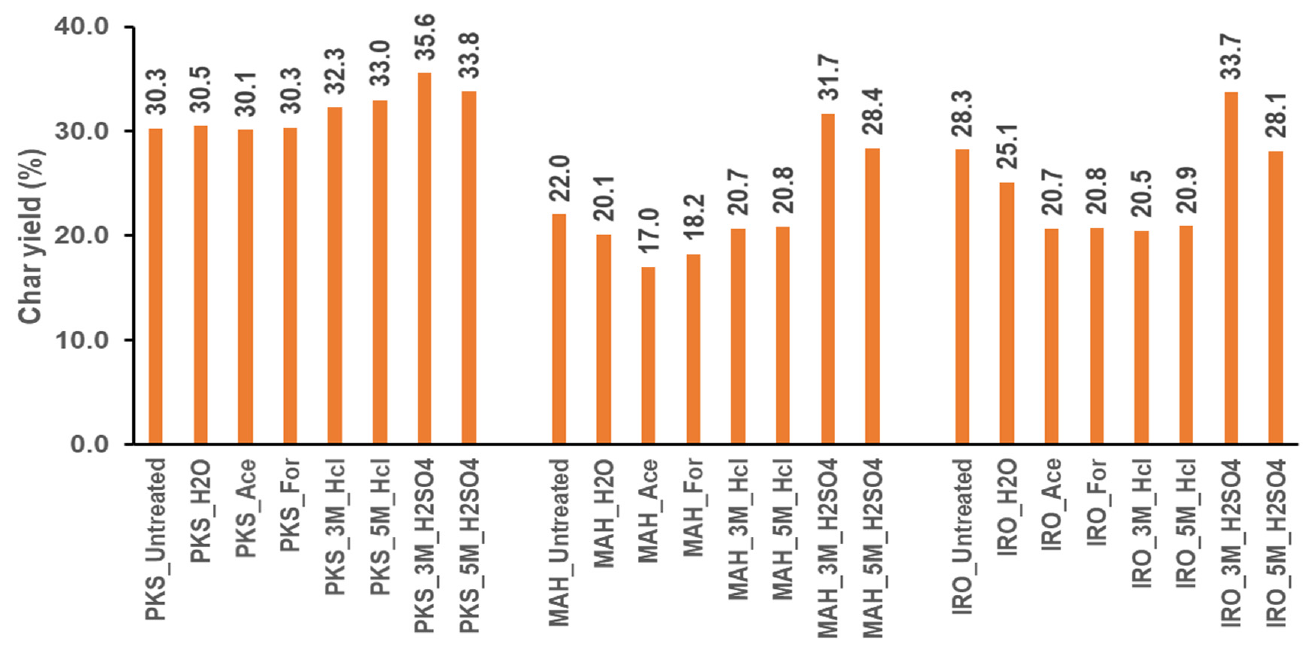
Figure 3. Schematic of the raw and pretreated PKS, MAH and IRO final residue obtained from the TGA analysis in nitrogen atmosphere at 600 °C. Average standard deviation for all samples was ˂ 1.1%.